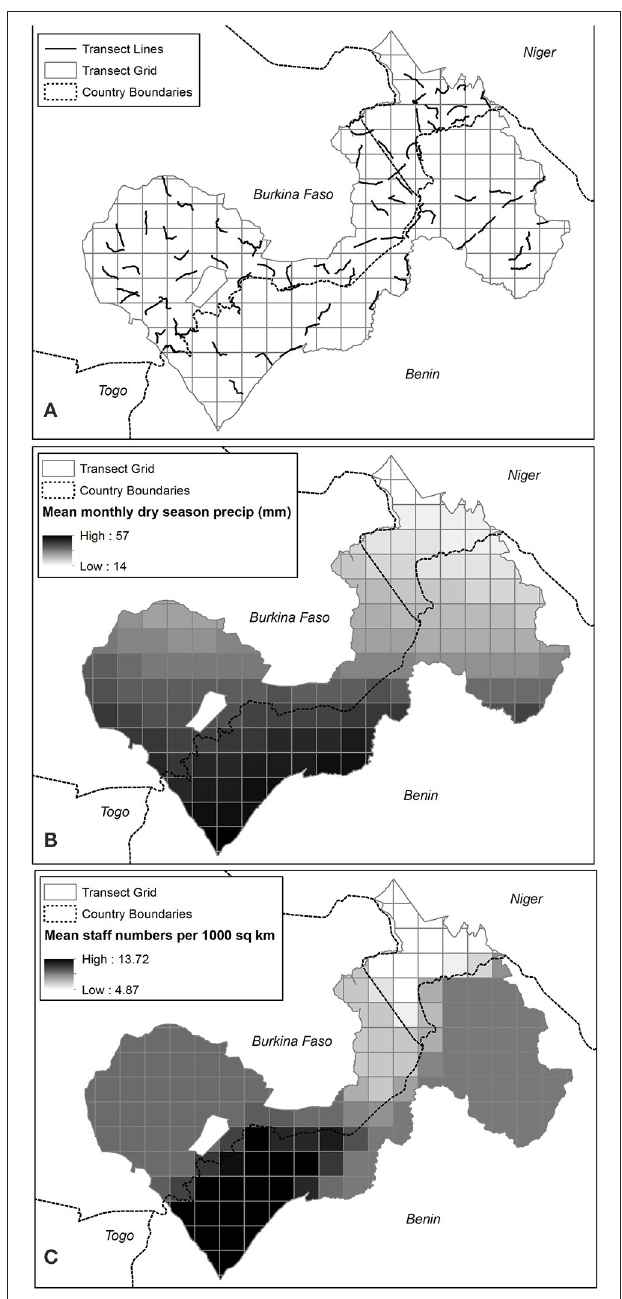
FIGURE 2 | (A) Seventy-four 15-km transects conducted within 225-km 2 sampling units of W-Arly-Pendjari (WAP) (B) Mean monthly dry season (March to May) precipitation (mm) in WAP sampling units (C) Mean staff numbers (in number of staff/1000km 2 ) in WAP sampling units.